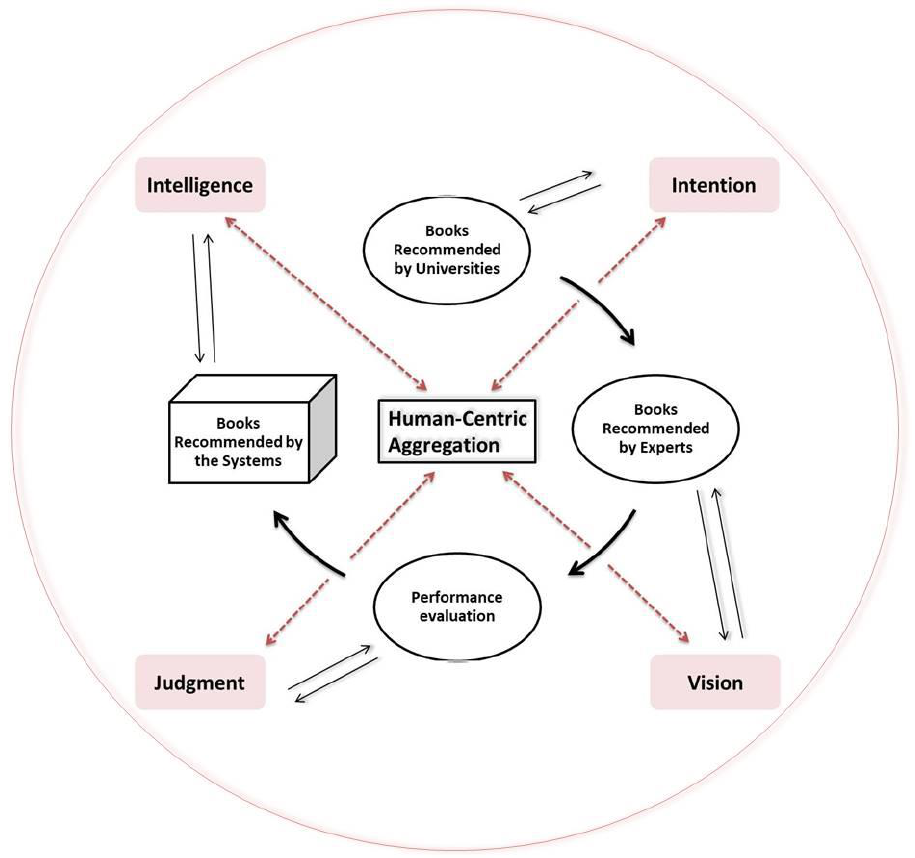
Figure 8. Book recommendation from the perspective of human-centric aggregation approach. The human-centric factors are shown via double arrow and curved arrow representing the connection in recommendation mechanism.